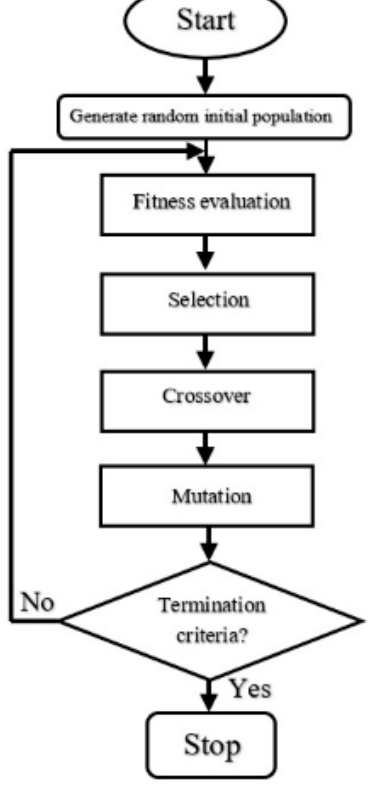
Figure 6. GA optimization process.